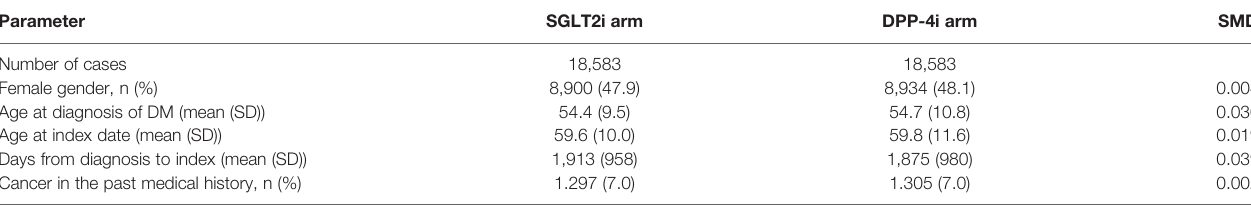
TABLE 1 | Selected clinical parameters of the SGLT2i arm vs . the DPP-4i arm after the propensity score matching. Parameter Number of